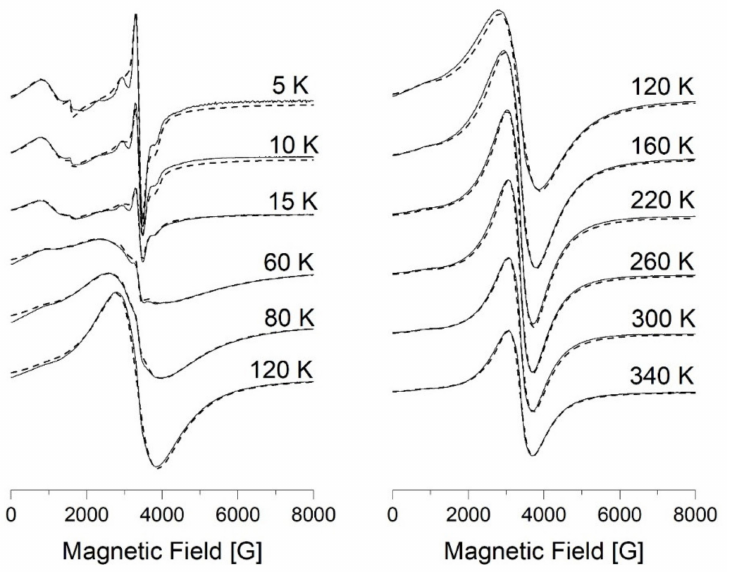
Figure 5. The temperature dependence of the EPR X-band spectra of 2 from 5 K to 340 K. The dashed lines show the theoretical EPR